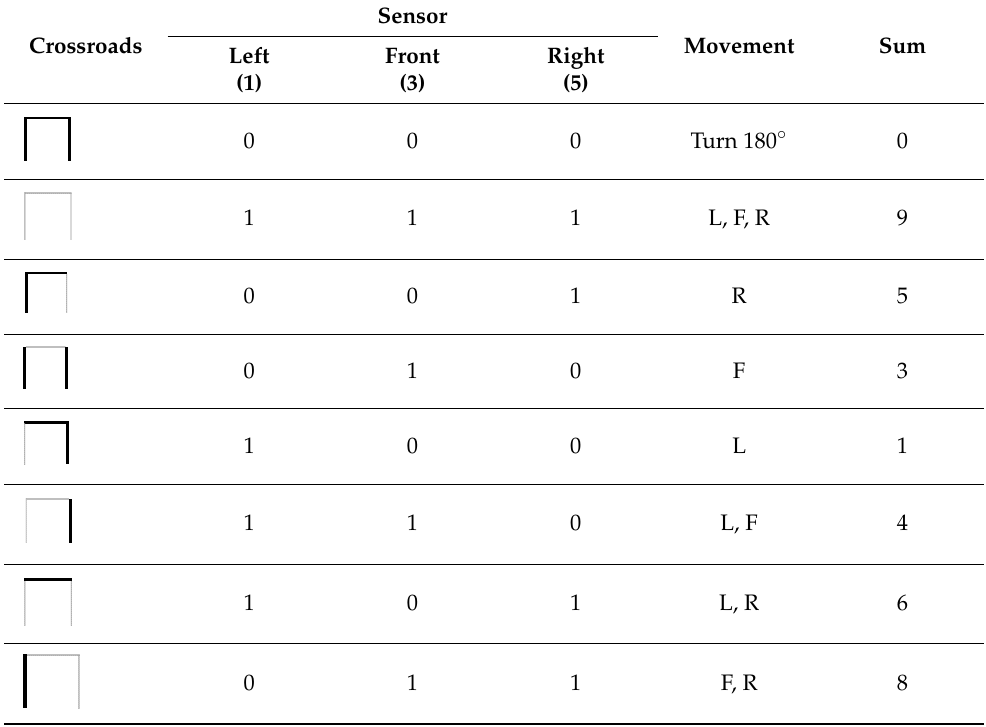
Table 1. Decision table for the random mouse algorithm. L, left; F, front; R, right. Crossroads